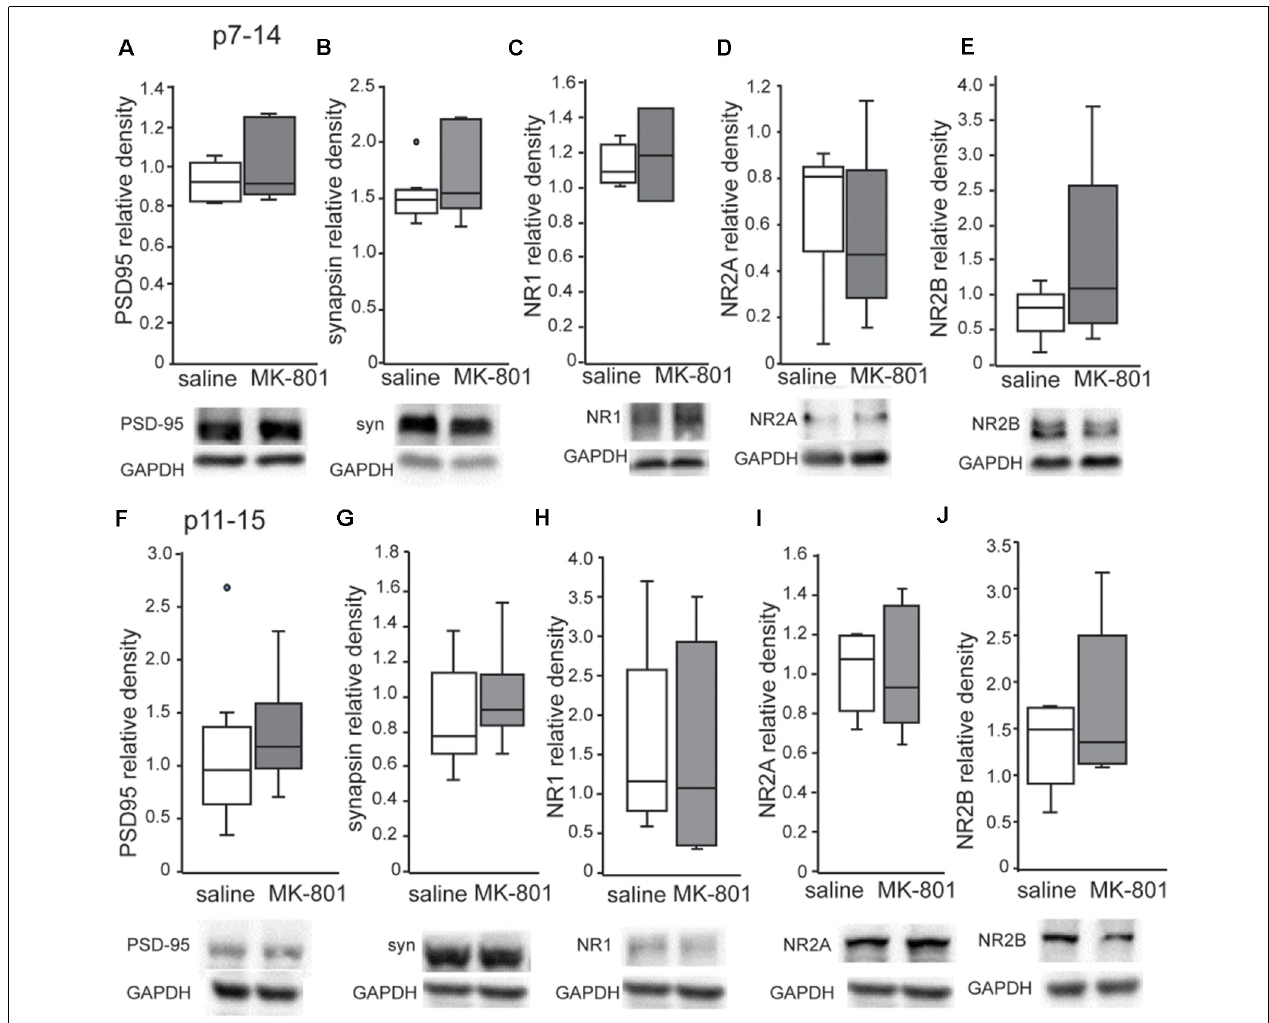
FIGURE 6 | Expression of PSD-95, synapsin, NR1, NR2A and NR2B in the HPC of nMK-801 (p7–14; n = 6) and nMK-801 (p11–15; n = 6) compared to saline-treated controls ( n = 6 + 6, 12 total). (A) No differences are identified in the PSD95 relative density in the HPC of nMK-801 (p7–14) compared to saline-treated ( t -test, p = 0.4). (B) No differences are identified in the synapsin relative density in the HPC of nMK-801 (p7–14) compared to saline-treated ( t -test, p = 0.4). (C) No differences are identified in the NR1 relative density in the HPC of nMK-801 (p7–14) compared to saline-treated ( t -test, p = 0.6). (D) No differences are identified in the NR2A relative density in the HPC of nMK-801 (p7–14) compared to saline-treated ( t -test, p = 0.5). (E) No differences are identified in the NR2B relative density in the HPC of nMK-801 (p7–14) compared to saline-treated ( t -test, p = 0.2). (F) No differences are identified in the PSD95 relative density in the HPC of nMK-801 (p11–15) compared to saline-treated ( t -test, p = 0.7). (G) No differences are identified in the synapsin relative density in the HPC of nMK-801(p11–15) compared to saline-treated ( t -test, p = 0.3). (H) No differences are identified in the NR1 relative density in the HPC of nMK-801 (p11–15) compared to saline-treated ( t -test, p = 0.75). (I) No differences are identified in the NR2A relative density in the HPC of nMK-801 (p11–15) compared to saline-treated ( t -test, p = 0.9). (J) No differences are identified in the NR2B relative density in the HPC of nMK-801 (p11–15) compared to saline-treated ( t -test, p =